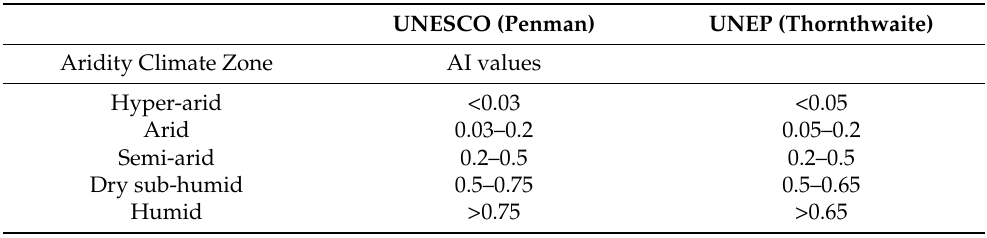
Table 3. Aridity index (AI) threshold values for climatic aridity zone classification according to UNESCO and UNEP classification